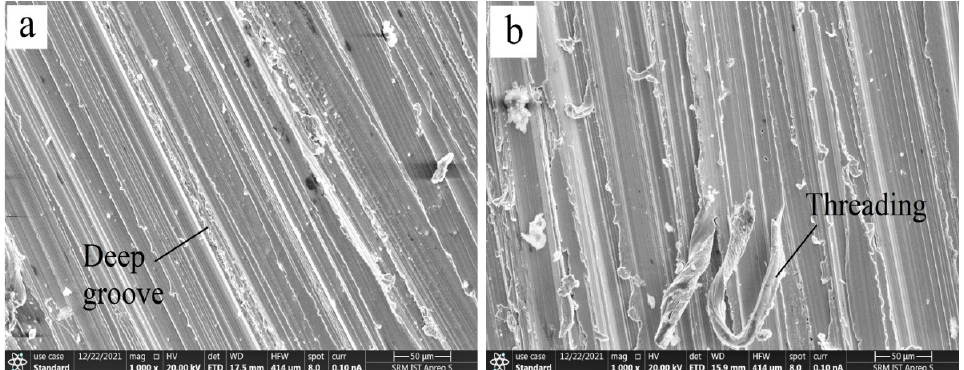
Figure 7. Wear morphology of DCT 1 sample showing ( a ) deep grooves and ( b ) thread ‐ like pullout.